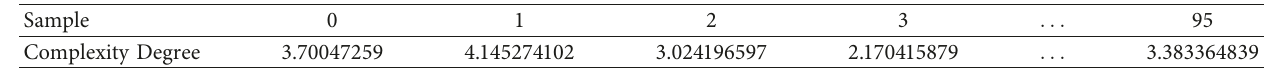
Table 9: Complexity degree of samples.